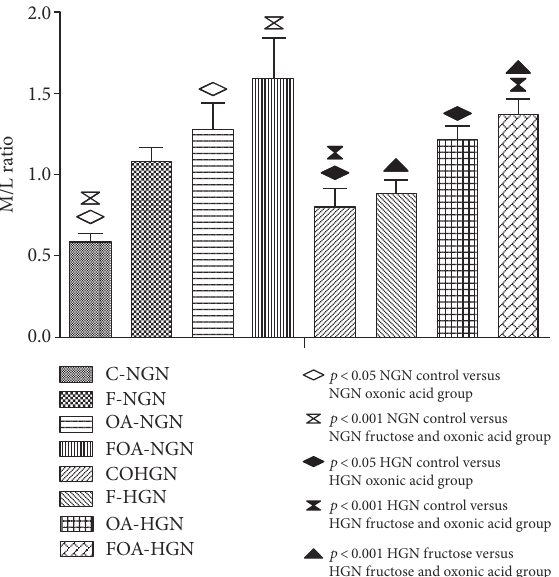
Figure 4: Media/lumen (M/L) ratio of renal arteriole. NGN (normogonadic); HGN (hypogonadic); C (control); F (fructose); OA (oxonic acid); FOA (fructose and oxonic